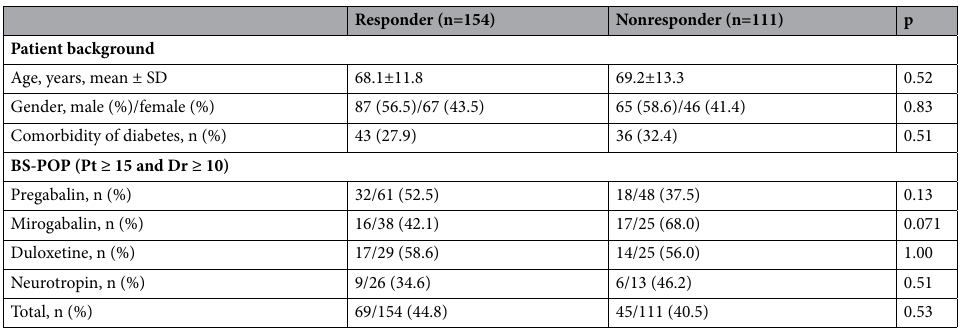
Table 6. Differences in patient background and the number of participants with a BS-POP score of ≥ 15 for patients or ≥ 10 for doctors between responders and nonresponders. Data are shown as the number of applicants/total number (%). BS-POP Brief Scale for Psychiatric Problems in Orthopaedic Patients.